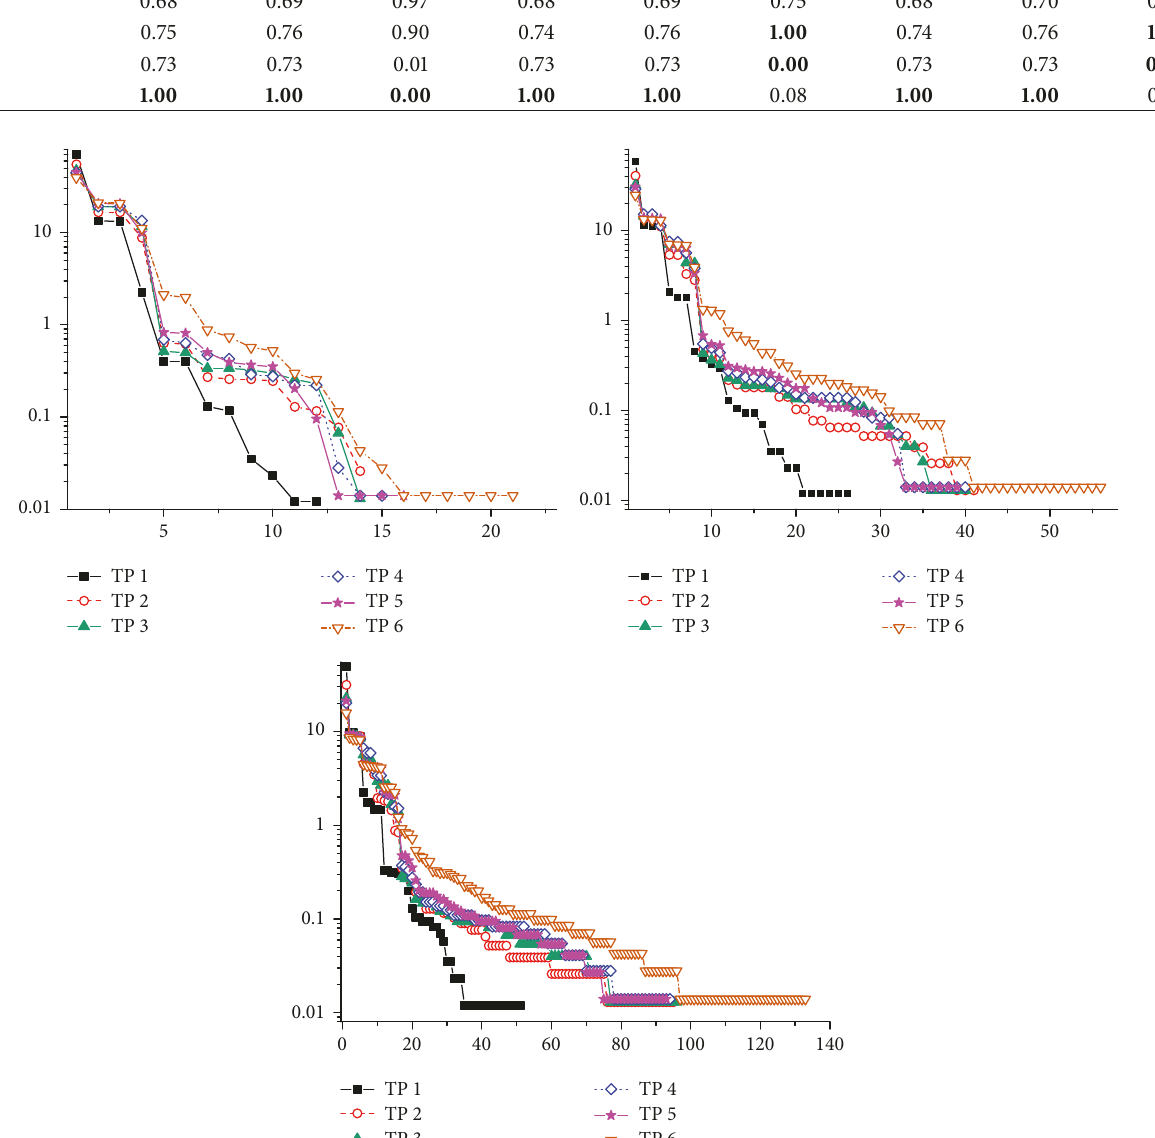
Figure 4: Zipfian distribution of 2-, 3-, and 4-gram word length block frequencies (the abscissa represents rank and the ordinate represents log